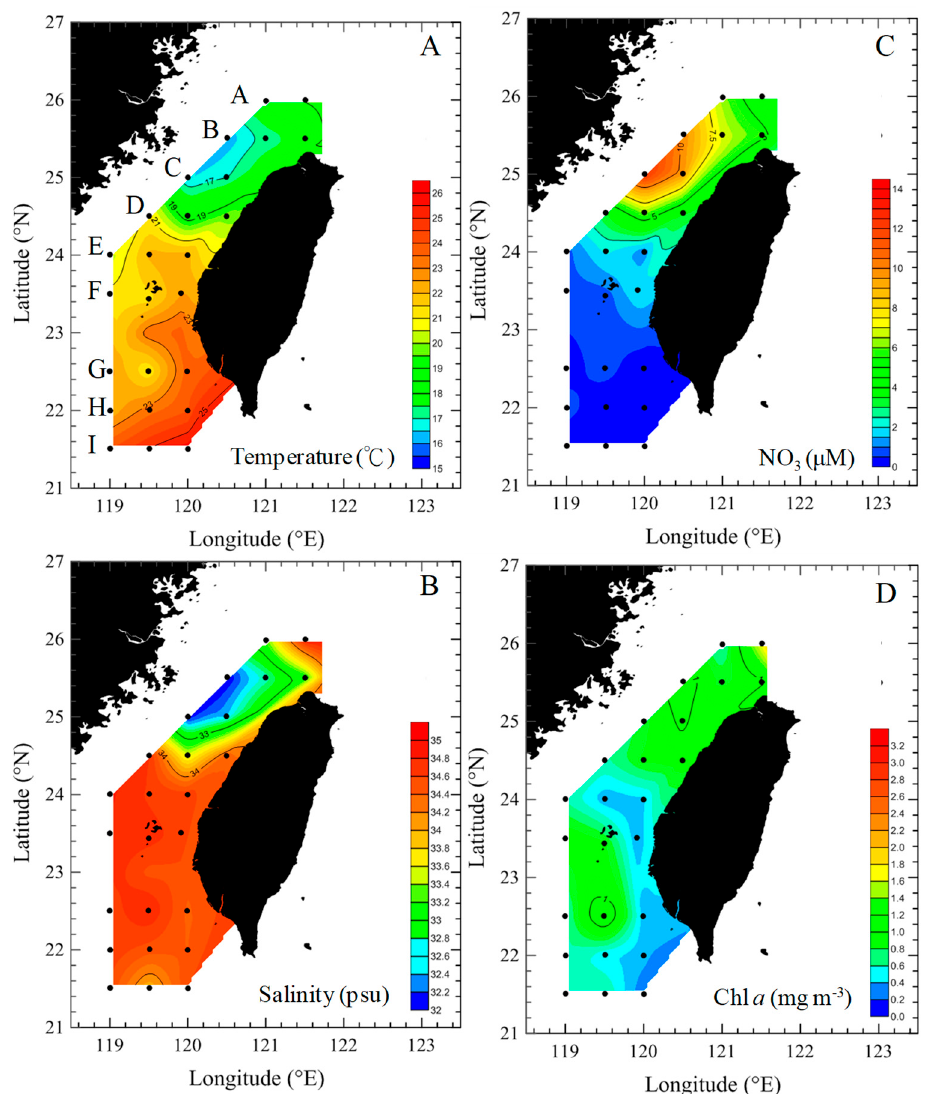
Figure 1. Spatial variations of temperature ( A ), salinity ( B ), NO 3 ( C ), and Chl a concentrations ( D ) during the study period in the Taiwan Strait.